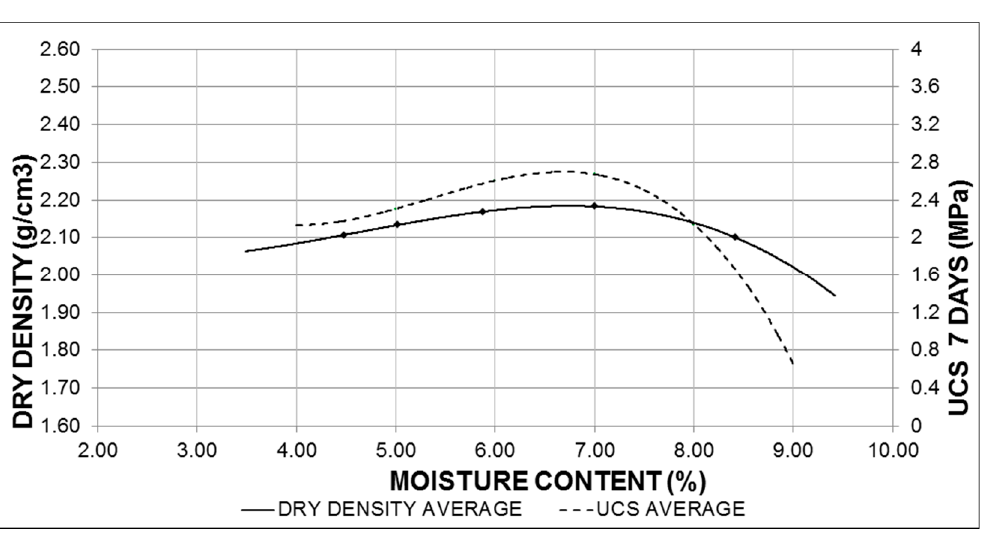
Figure 4. Modified Proctor density of the soil-cement with a 3.5% content of cement.